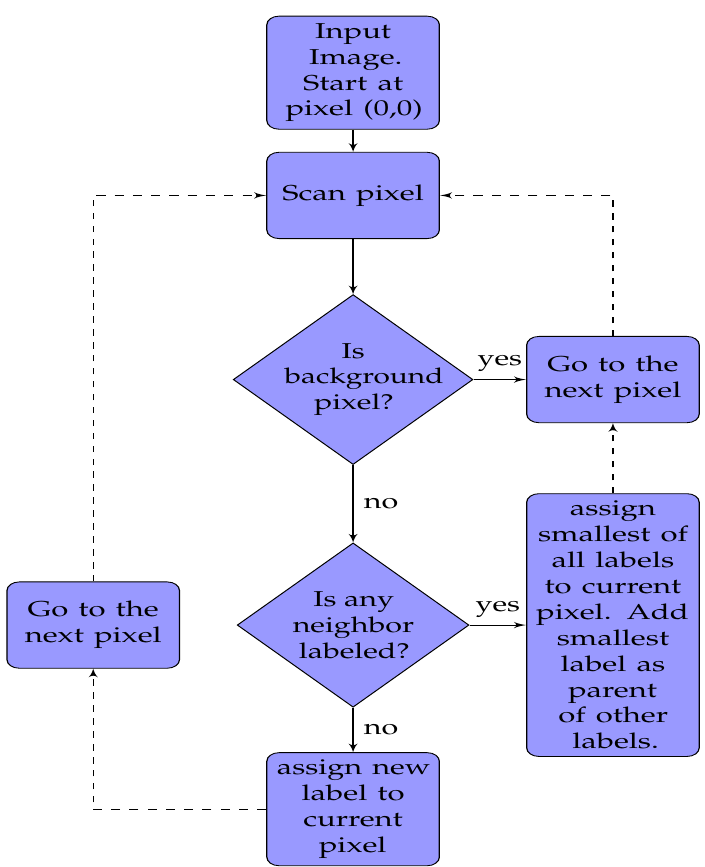
Figure 4. Connected Components algorithm first pass: assigning labels.